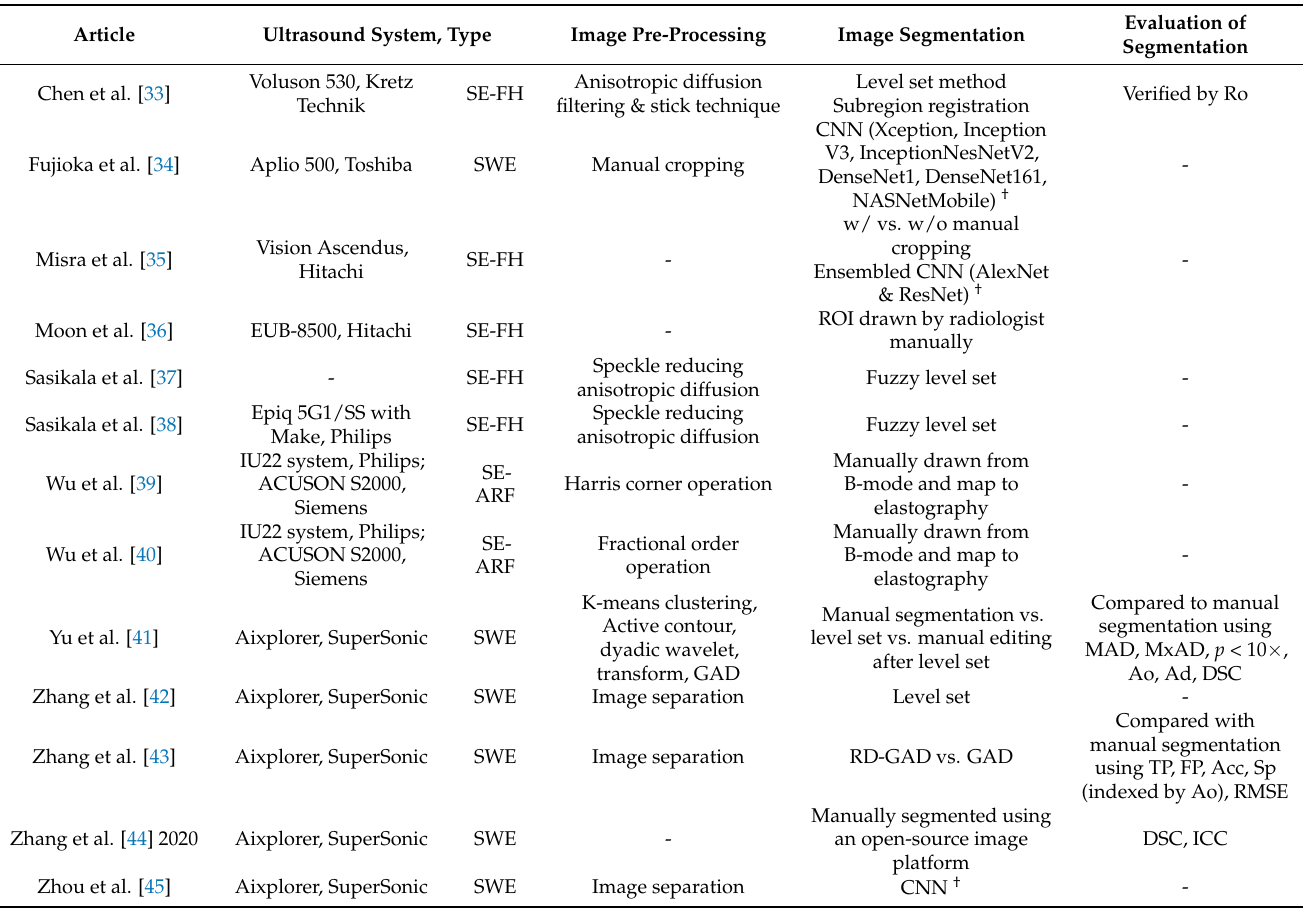
Table 2. Configuration of the ultrasound system and image